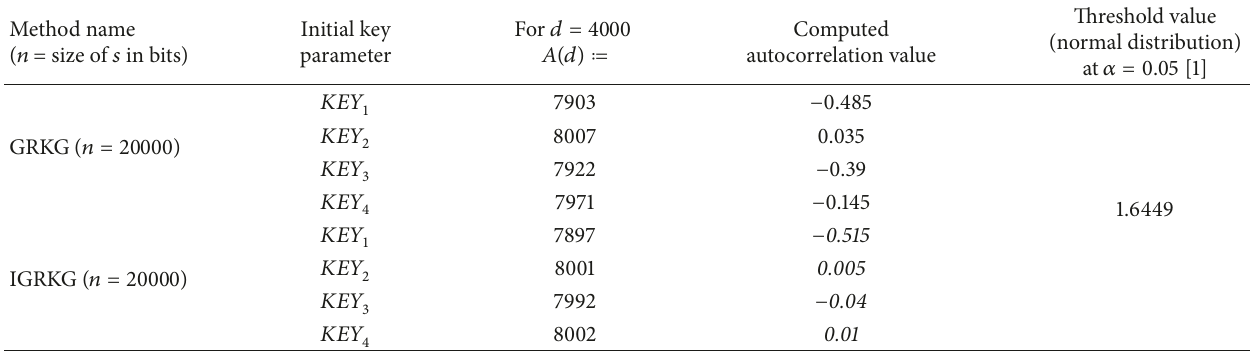
Table 9: 𝑇𝑒𝑠𝑡 3 values for a binary sequence 𝑠 of size 𝑛 = 20000 , where 𝑠 is generated individually from both the GRKG and the IGRKG generators corresponding to four different input 𝐾𝐸𝑌 parameters that have been mentioned in Table 6.